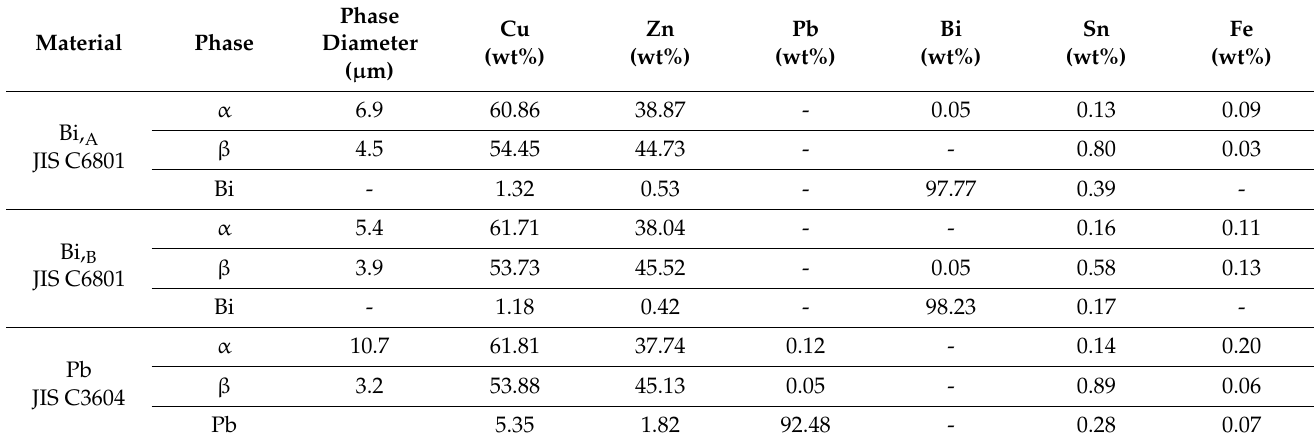
Table 1. Chemical composition of the α , β , Bi and Pb phases.